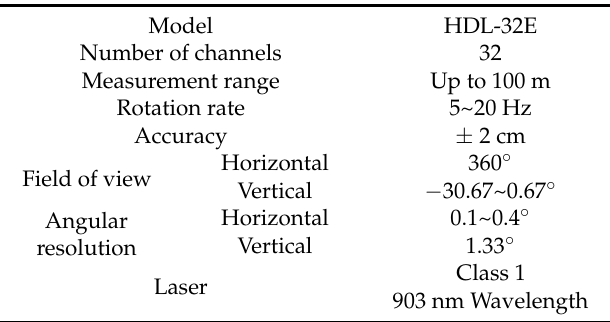
Table 2. Specifications of the mobile laser scanner.